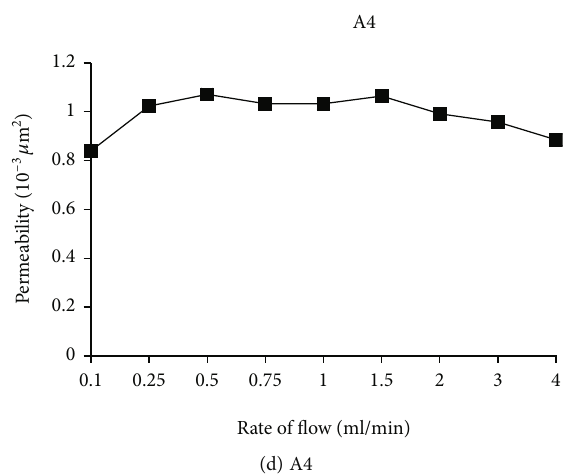
Figure 6: The relationship between reservoir fl ow rate and